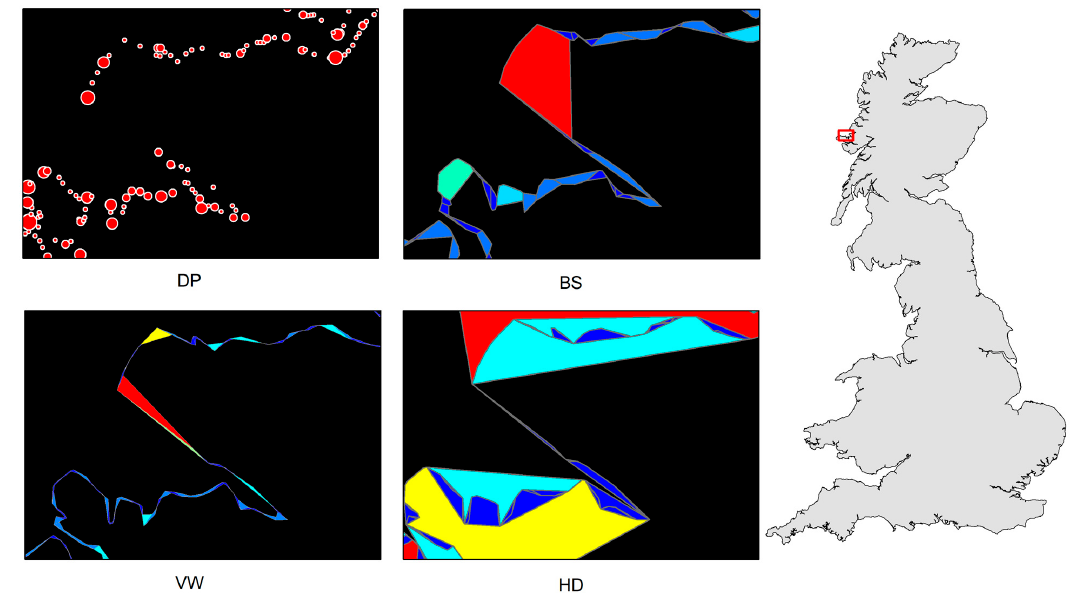
34.83 Table 2. Ht-index of three parameters for each algorithm on the source data of the British coastline. (Note: 40% as threshold for the head/tail breaks process).